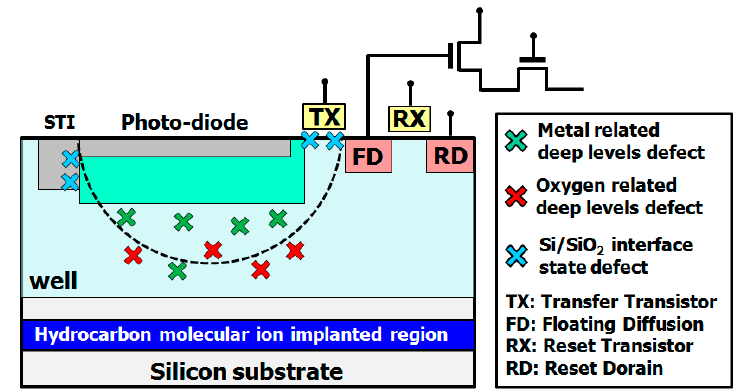
Figure 1. Technological issues of CMOS image sensor fabrication. Modified from Kurita et al. [29], Copyright (2016) The Japan Society of Applied Physics.